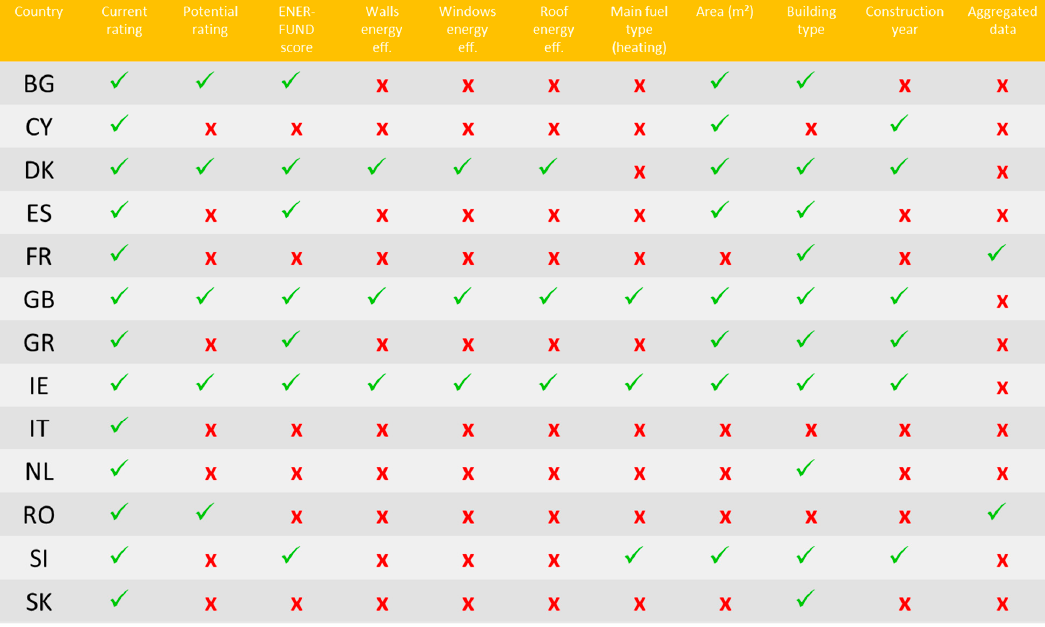
Figure 3. Type of data available per country.